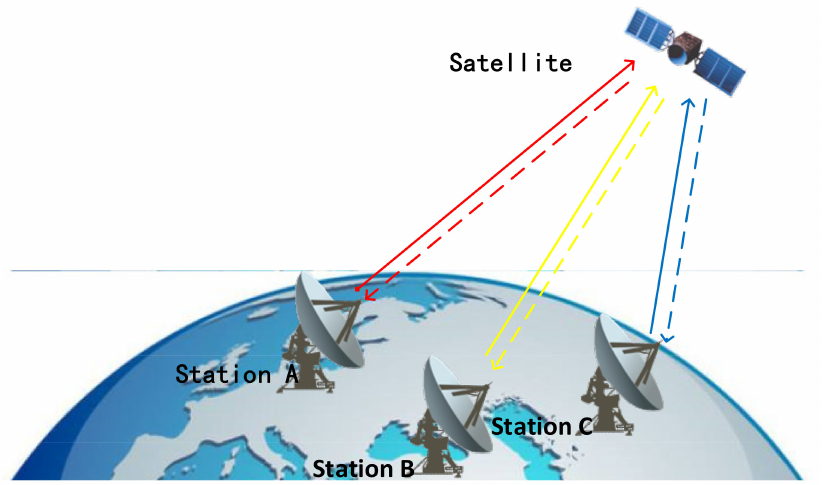
Figure 1. Self-transmitting and self-receiving observation mode. Table 1. The measurement models and reference systems in orbit